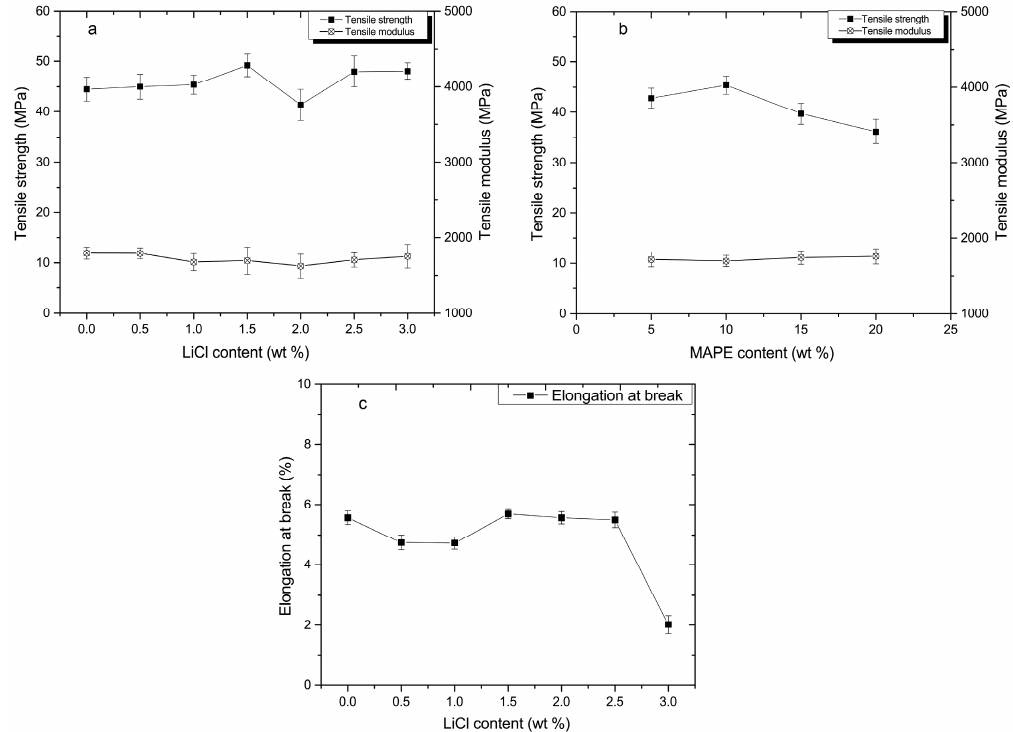
Figure 3. Tensile properties of composites: ( a ) tensile strength and modulus in various LiCl contents; ( b ) tensile strength and modulus in various MAPE contents; and ( c ) the elongation at break in various LiCl contents.